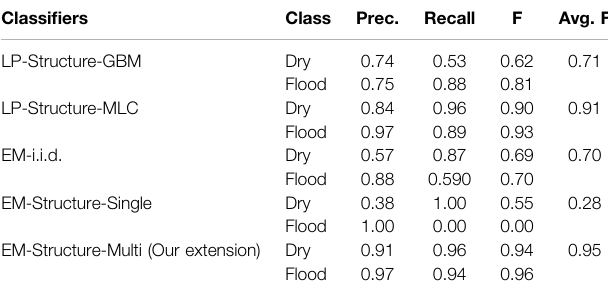
TABLE 7 | Comparison on Mathew, Grimesland fl ood data.